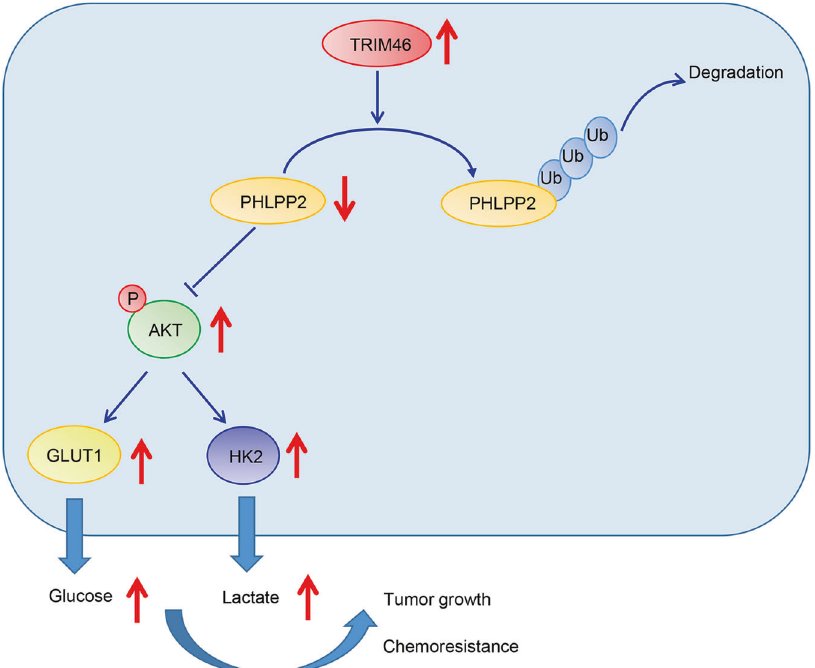
Fig. 8 Depicting the possible molecular mechanisms by which TRIM46 regulates LUAD progression. TRIM46 activates AKT/HK2 signaling by modifying PHLPP2 ubiquitylation to promote glycolysis and chemoresistance of lung cancer